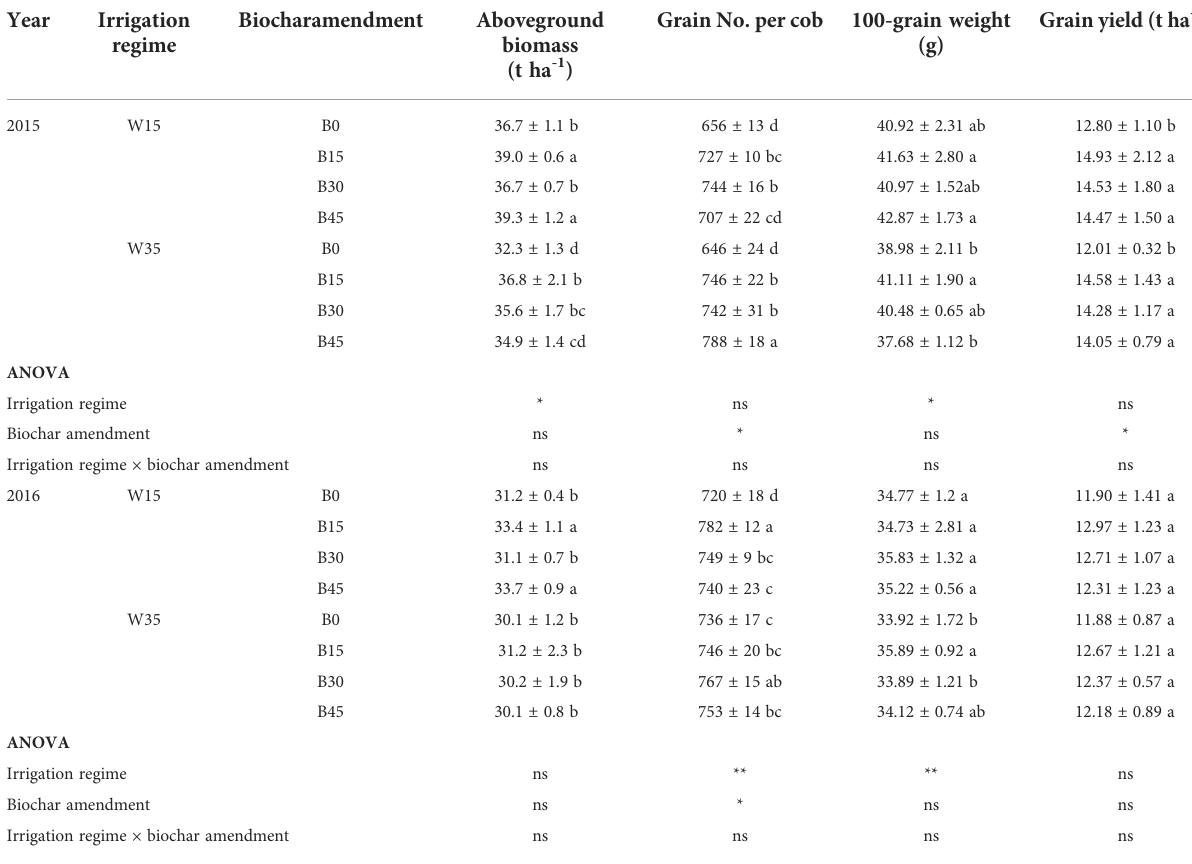
TABLE 4 Maize agronomic traits and yield components under biochar amendments (B0, B15, B30, and B45, referring as 0, 15, 30, and 45 t ha -1 ) and irrigation water lower limits at soil matric potential -15 (W15) and -35 kPa